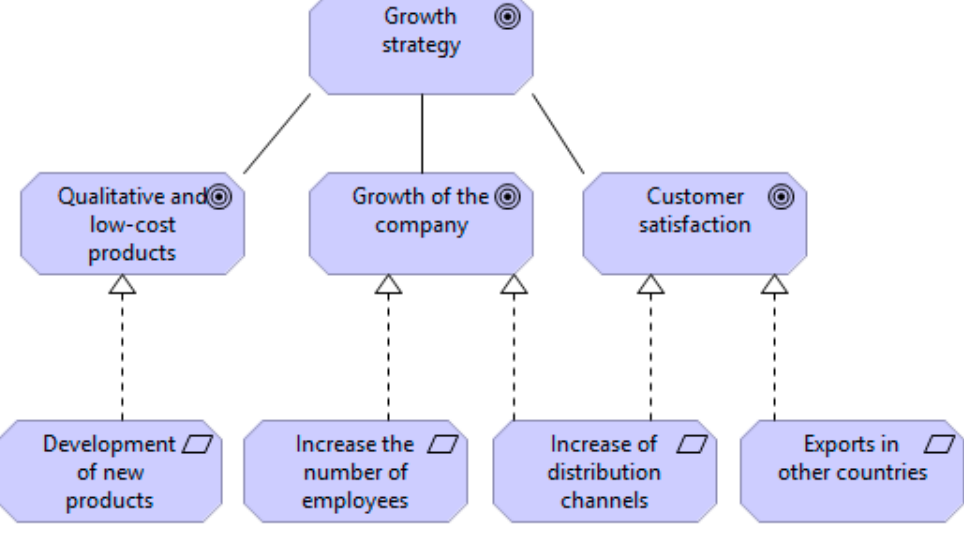
Figure 12. Implementation of a strategy.